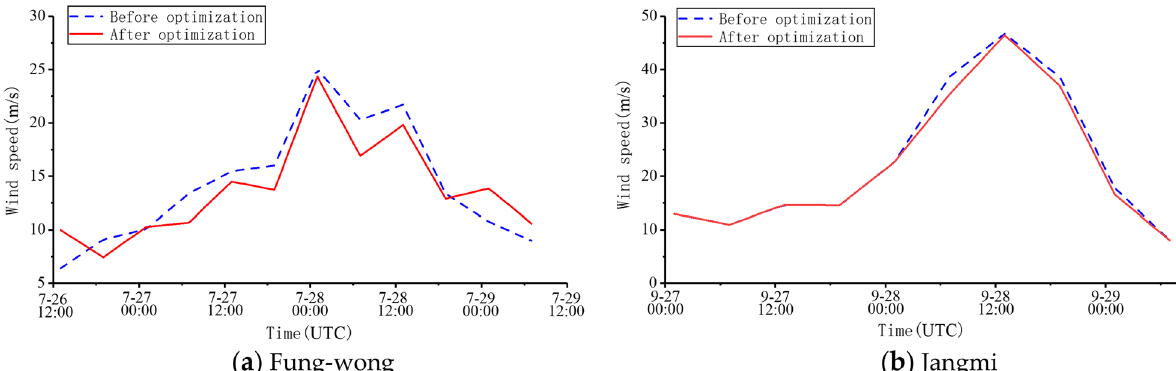
Fig. 6 Comparison of hourly variation curves of typhoon wind speed before and after optimization